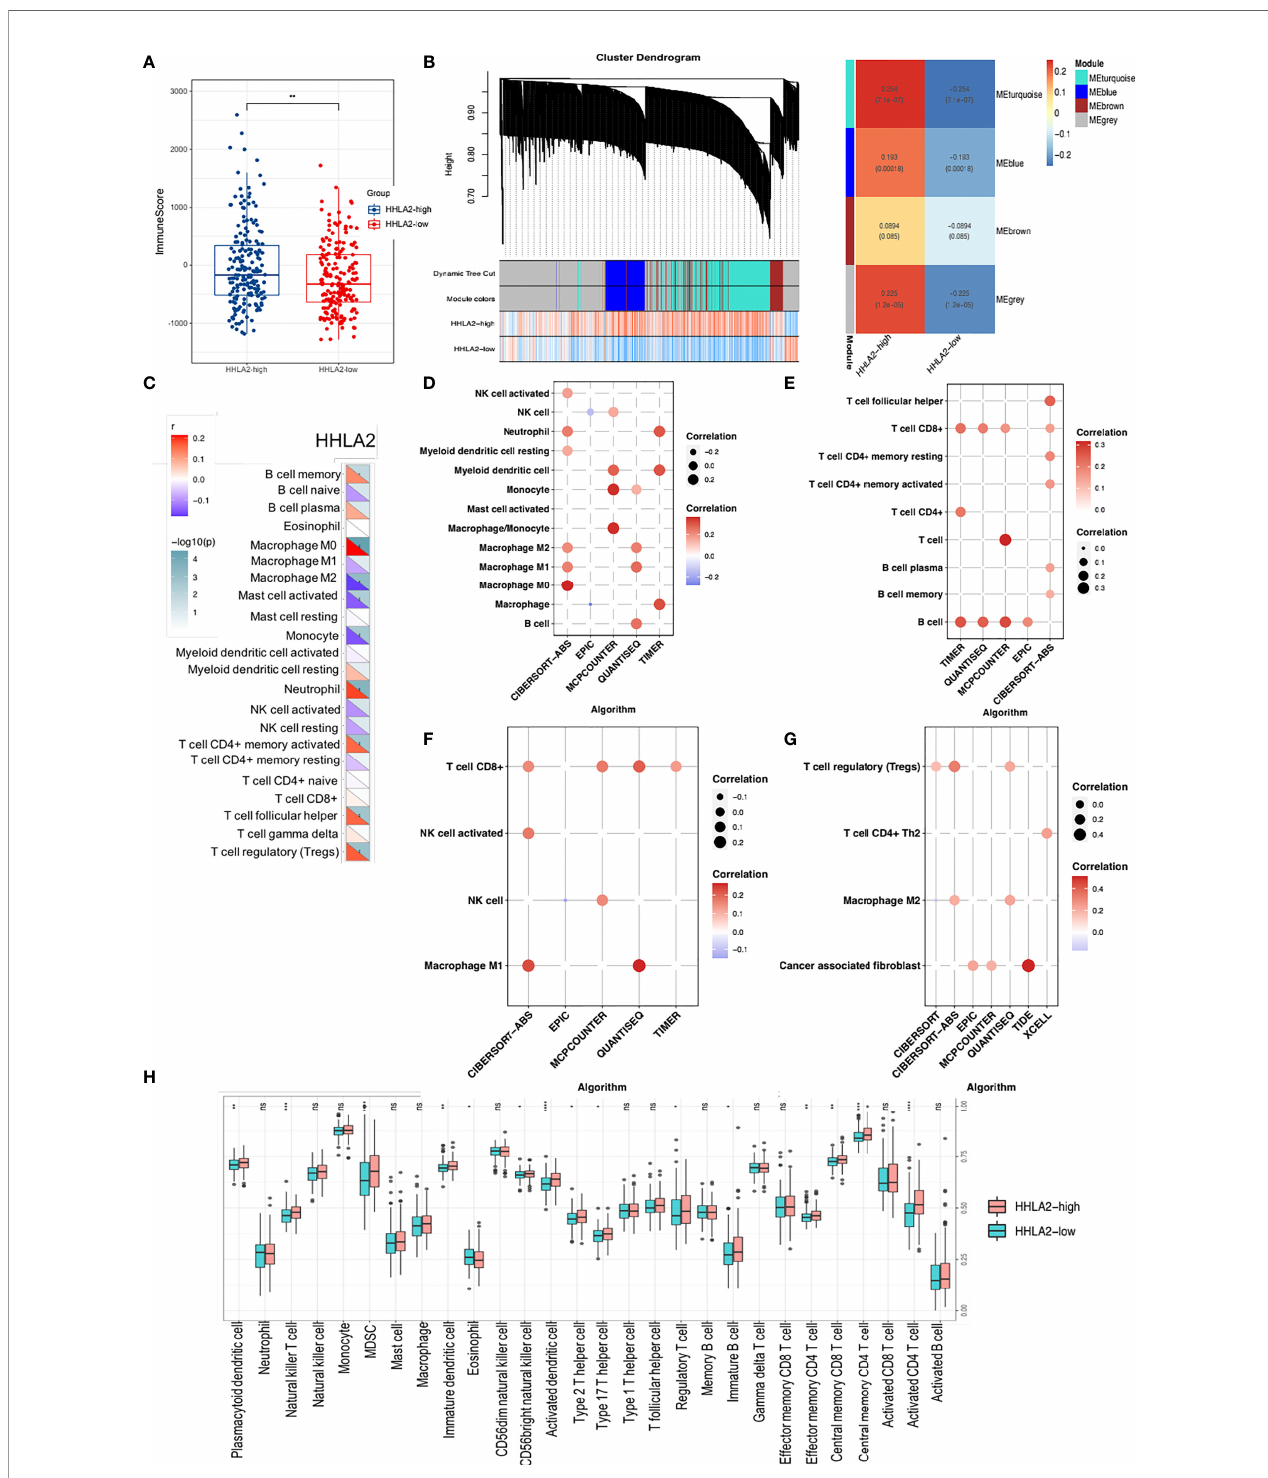
FIGURE 4 | Comprehensive analysis of HHLA2 and the tumor immune microenvironment (TIME). (A) Distribution of immune score between subgroups. (B) WGCNA analyses of HHLA2-high-related gene modules. (C) Correlation of HHLA2 expression with immune in fi ltration levels by CIBERSORT. (D) Correlation between HHLA2 and innate immune cells. (E) Correlation between HHLA2 and adaptive immune cells. (F) Correlation between HHLA2 and effector immune cells. (G) Correlation between HHLA2 and immunosuppressive immune cells. (H) Differences in in fi ltrating immune cell types between the high and low subgroups by ssGSEA. *p < 0.05, **p < 0.01, ***p < 0.001, ****p < 0.0001. ns, not signi fi